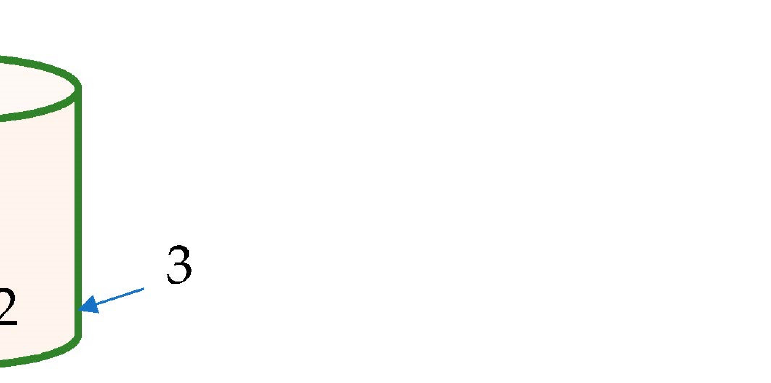
from the detector’s center. the detector’s center.